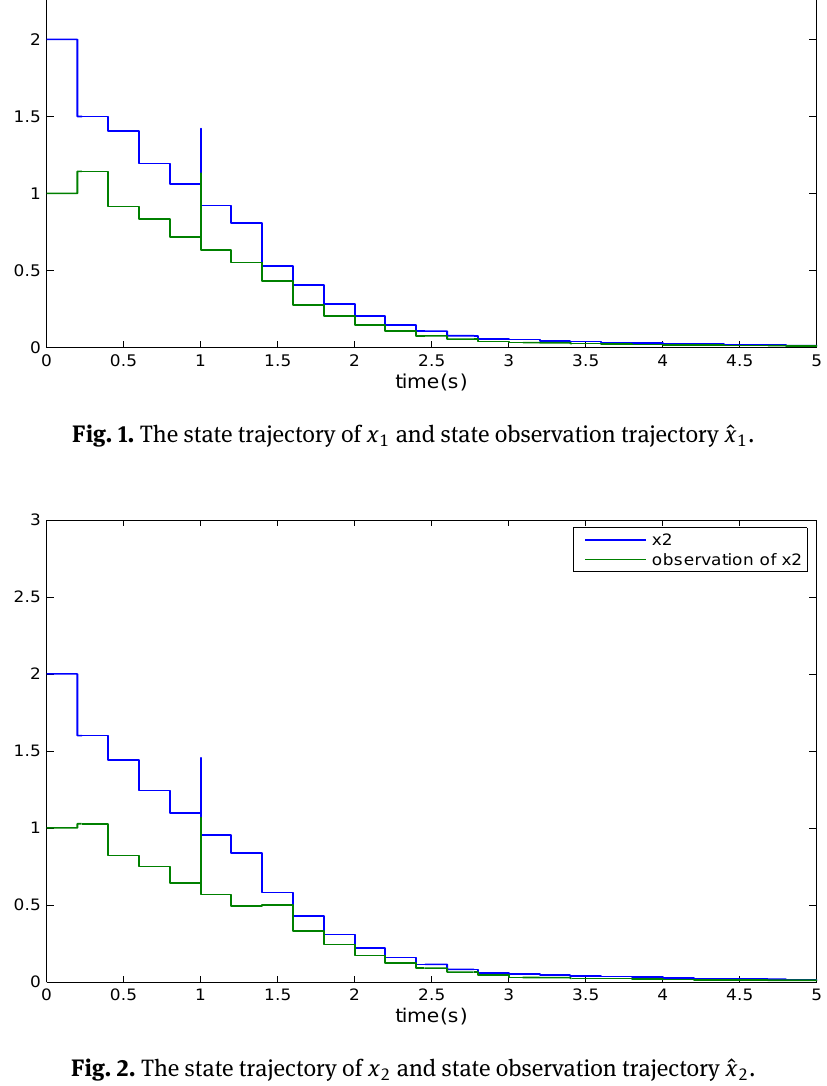
Fig. 2. The state trajectory of x 2 and state observation trajectory ˆ x 2